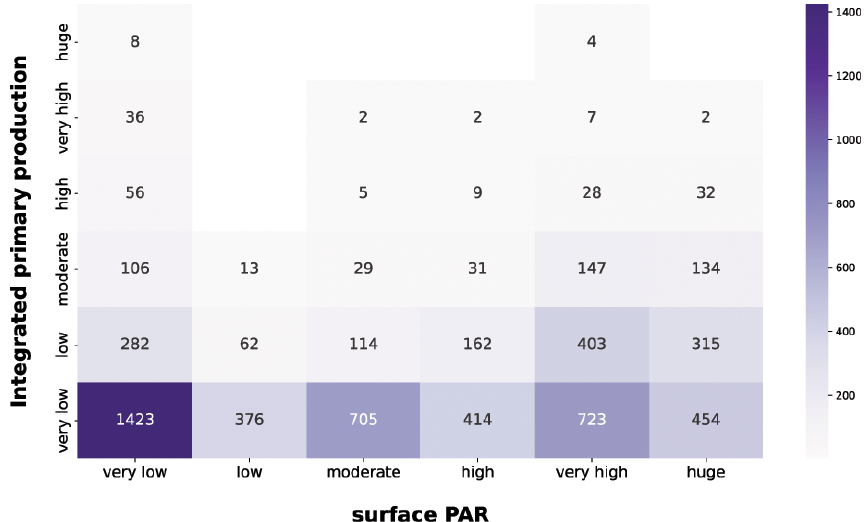
Figure 14. IPP vs. PAR. The purple heatmap shows how integrated phytoplankton production and PAR are related to each other.